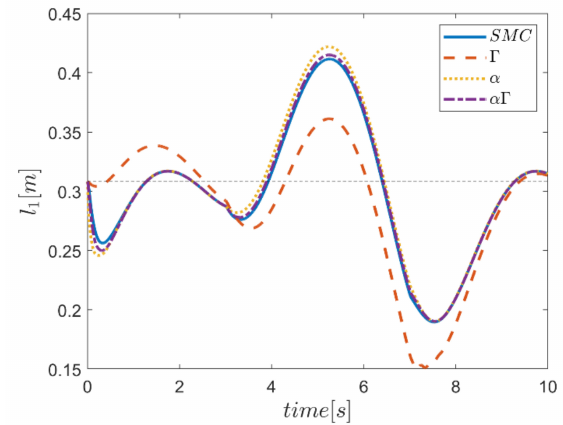
Figure 56. Comparison of the length of the first